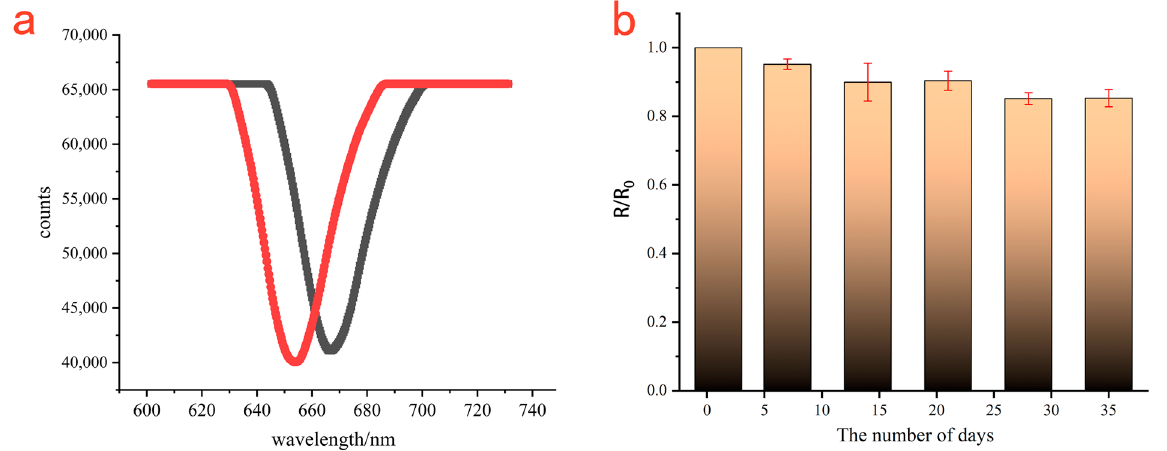
Figure 4. The resonance spectra of PBS on the SPR sensing chip before and after modification with T2-OVA ( a ); the stored stability of T2-OVA-modified Au film ( b ).